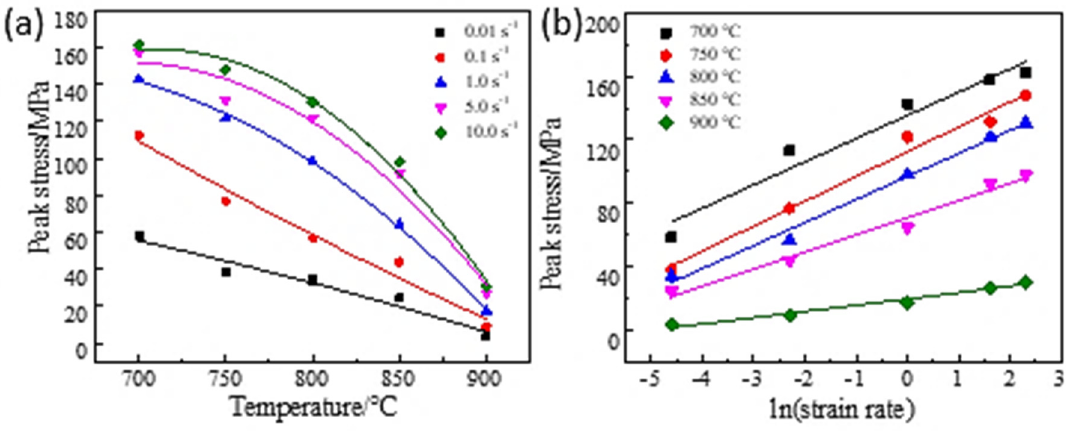
Figure 4. Dependence of peak stress on temperature and strain rate: ( a ) T − σ ; ( b ) lnε(cid:4662) − σ . During the hot deformation of TA1, the hardening impact of strain hardening, dy- namic recovery, and dynamic recrystallization softening mechanism will cause the varia- tion of flow stress. The stress-strain curve has two stages: unsteady deformation and steady deformation. At the initial stage of deformation, namely unsteady deformation, the flow stress growths quickly within a very small range of strain increases; The strain en- dures to growth while the flow stress grows gradually in the steady-state deformation process. The flow stress rises slowly when the deformation temperature is at a low level, and the strain rate is high. The flow stress grows slowly to the peak value, then declines slowly, and finally tends to be stable under the condition of a low strain rate and high deformation temperature. Plastic deformation occurs in the stage of unsteady defor- mation. The interaction of epistatic faults in the slip system causes the dislocation density to increase speedily, resulting in dislocation entanglement and stacking, and finally forms cellular dislocation structure, resulting in higher stress for material deformation [18]. Hardening is dominant, and the flow stress grows rapidly in the stage of unsteady defor- mation. As the strain increases, the material accumulates more energy in the steady-state de- formation stage. Cellular dislocations form substructures, and dislocations of opposite signs are canceled out. The softening influence of dynamic recovery rises continuously, and the growing trend of flow stress becomes gentle. The material will have enough time to accumulate more energy at a large deformation temperature and a small strain rate [19]. Dynamic recrystallization will arise during the deformation after the material accumu- lates enough energy. At this time, the softening effect is more pronounced. The flow stress declines slowly after getting the peak value. Finally, the hardening effect affected by the rise of strain is balanced with the softening effect of dynamic recovery and dynamic